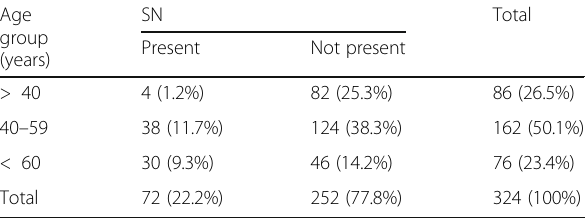
Table 3 Average age of SN-affected patients